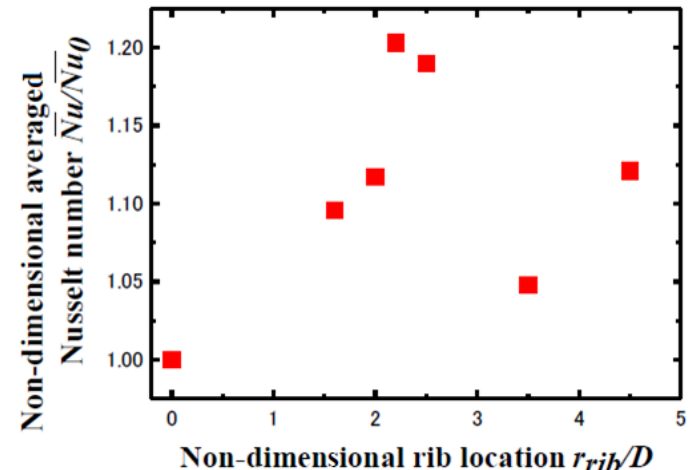
Figure 8. Effect of circular rib location on the averaged Nu (at the fixed circular rib height of e / δ = 1.0).